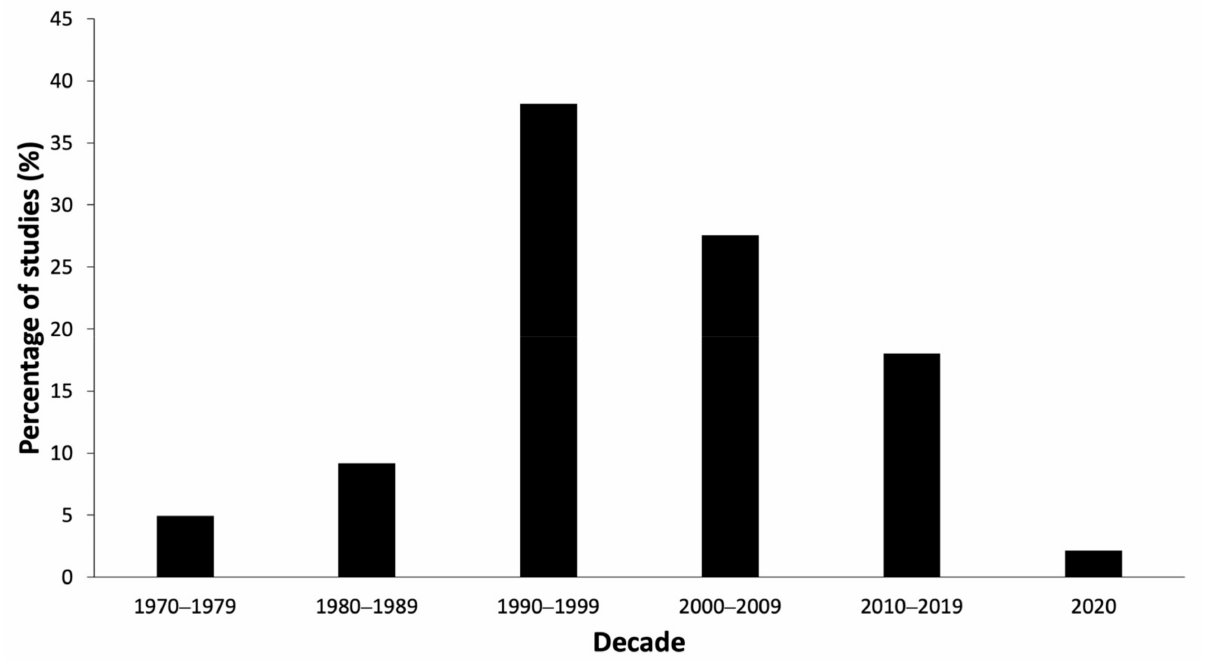
Figure 2. Distribution of selected papers by